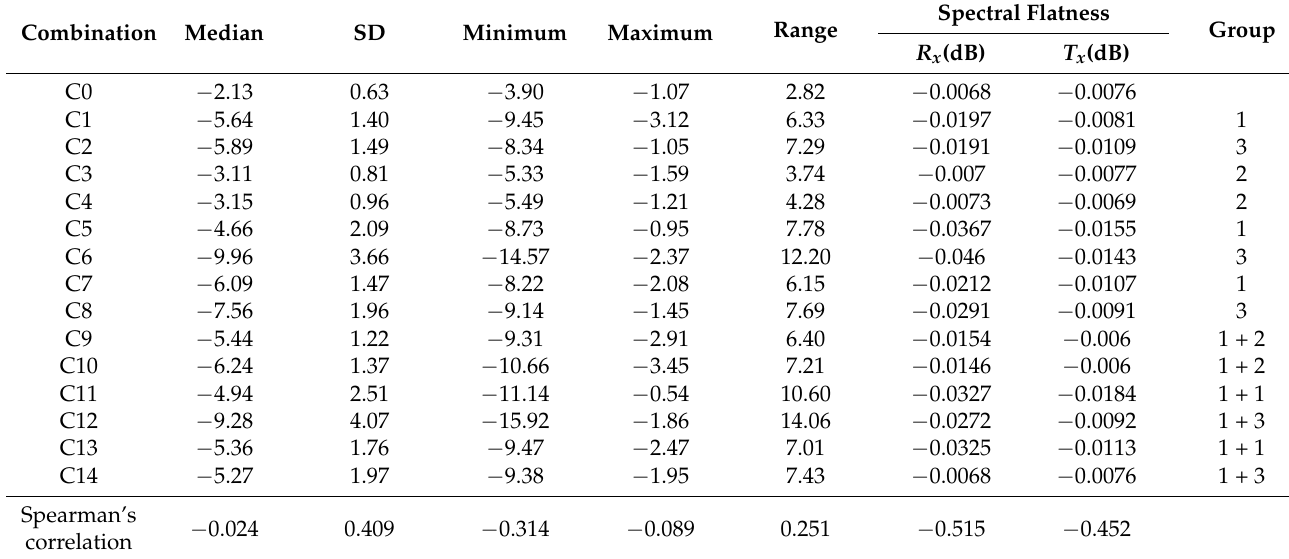
Table 6. Statistical analysis of A s in dB and spearman’s correlation between FER and signal describing parameters (statistical and